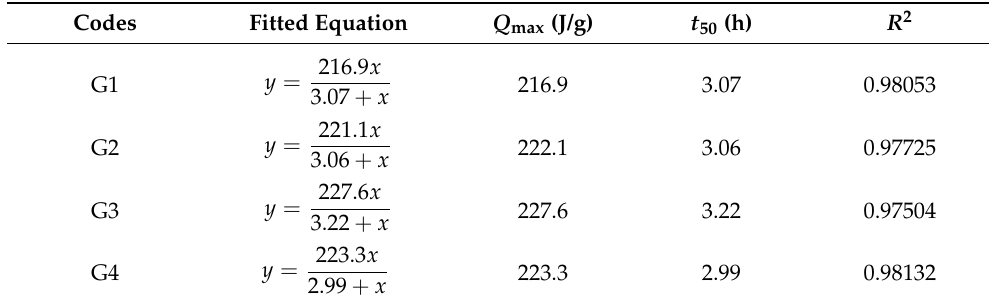
Figure 4. Knudsen equation linear fitting to calculate Q max ; ( a ) G1, ( b ) G2, ( c ) G3, ( d ) G4.